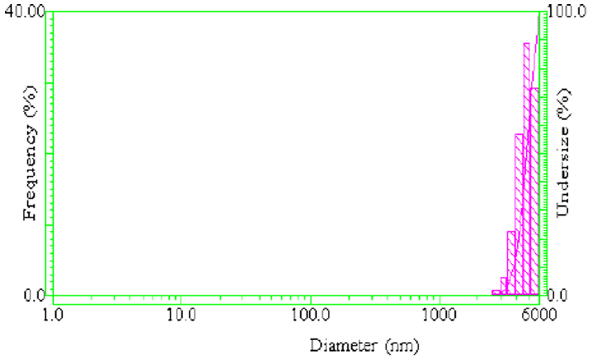
Fig. 2 Particle size distribution of bulk CMC